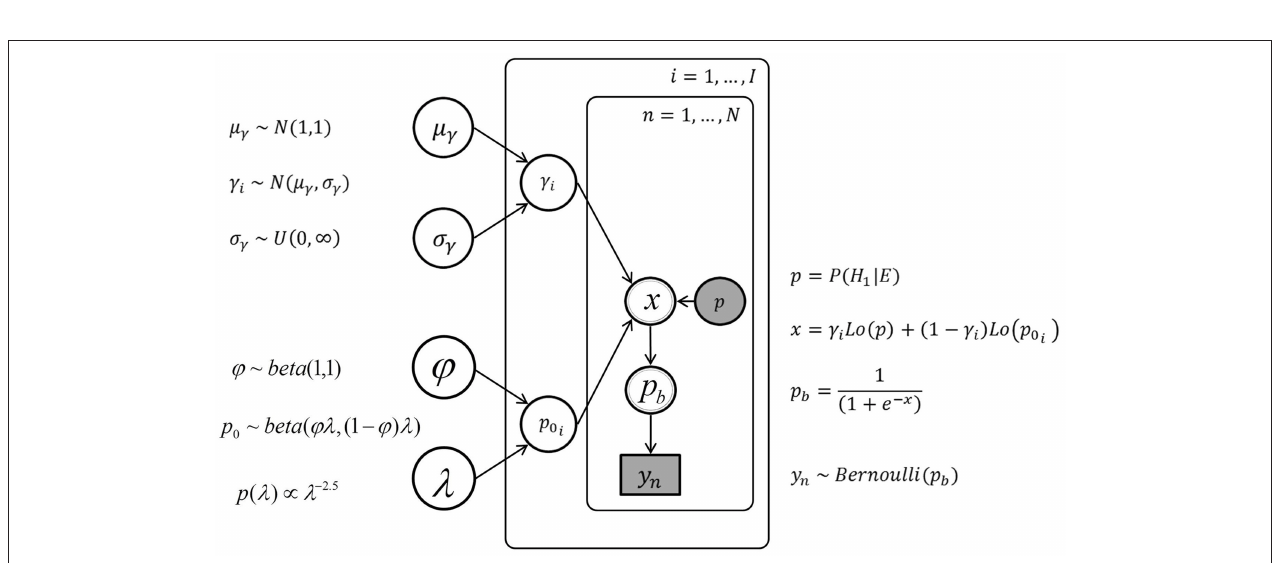
FIGURE 5 | The graph of the Bayesian network with unrestricted inter-individual differences, with the urn inference y n , the posterior probability p , and the individual parameters p 0 i and γ i .